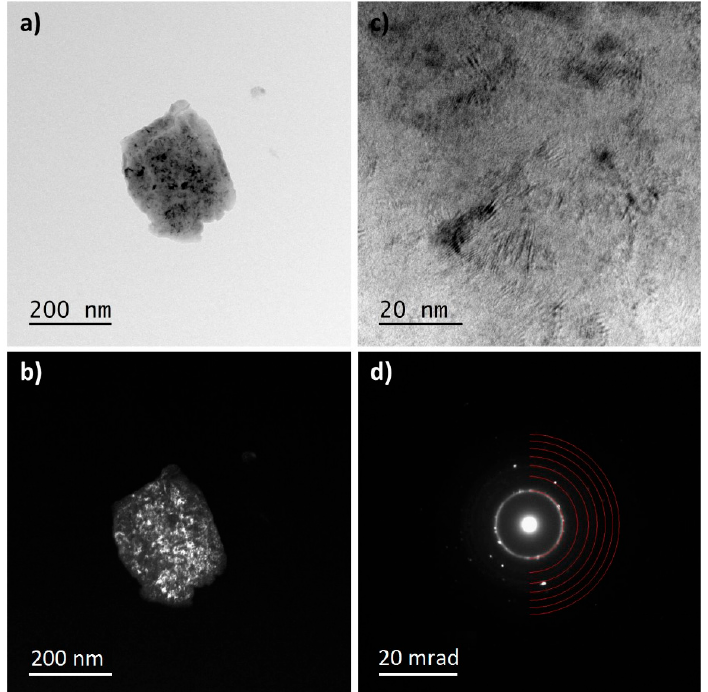
Figure 8. TEM analysis of the TTM powder milled for 100 h; ( a ) TEM bright ‐ field image; ( b ) TEM dark ‐ field images; ( c ) HR ‐ TEM image; and ( d ) SAED pattern of the β phase.